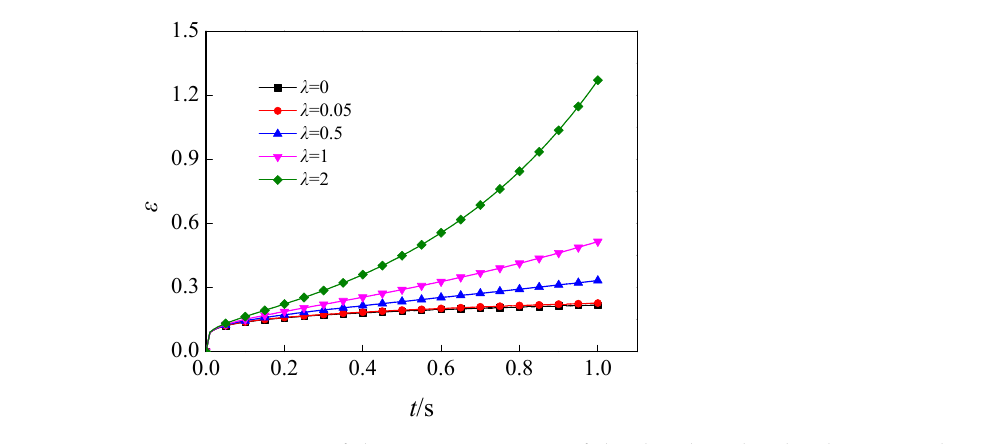
Figure 8. Curves of the creep properties of the distributed order damper with various damage parameters.